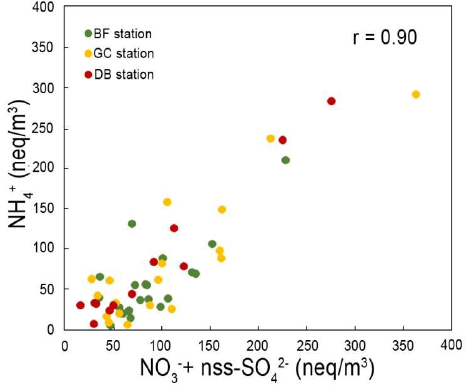
Figure 5. Plot of NO 3- +nss–SO 42- vs NH 4+ ion concentrations. Data expressed in neq/m 3 .